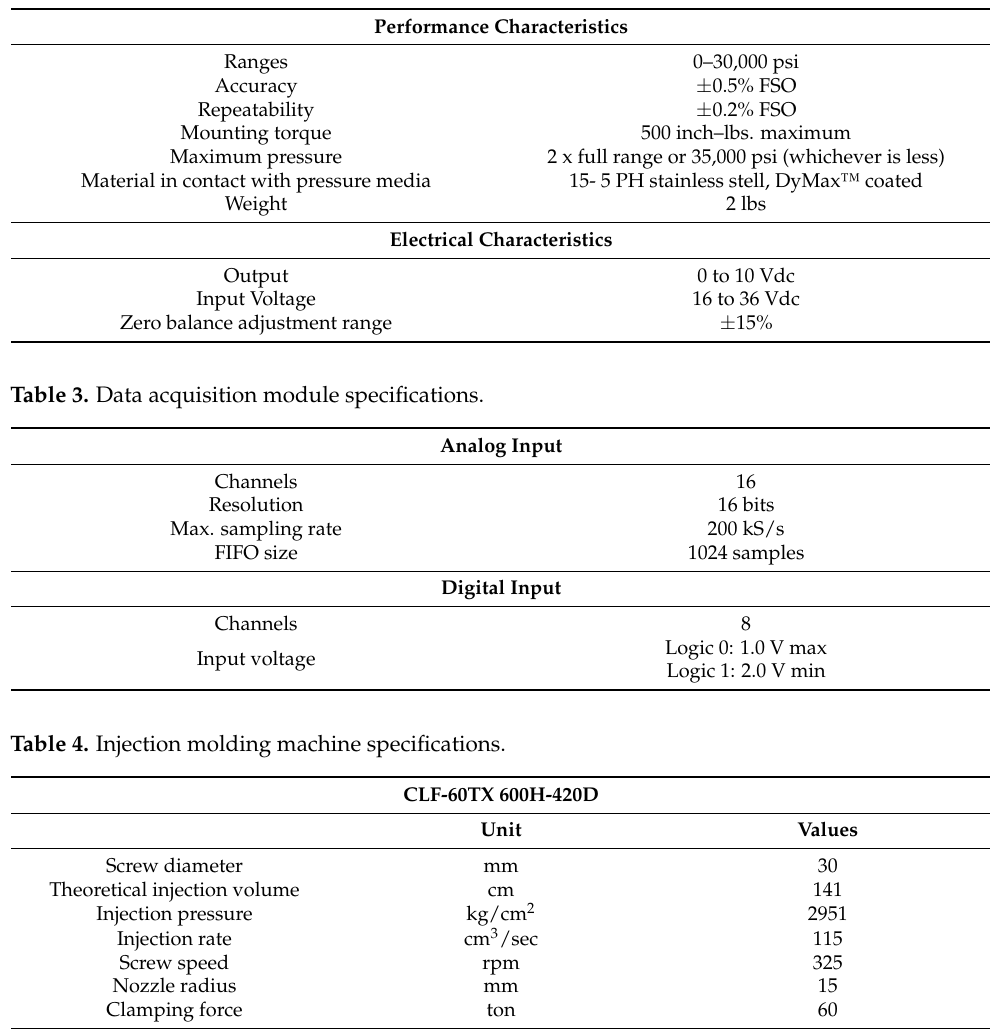
Figure 5. The mold of the thin disk sample. Table 2. Pressure sensor specifications.